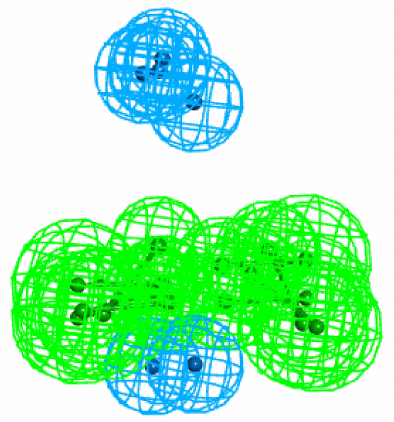
Figure 13. Pharmacophore overlap of the Hypo1_t-PNA, Hypo1_STR-CAR, Hypo1_STR-PNA and Hypo1_EXP